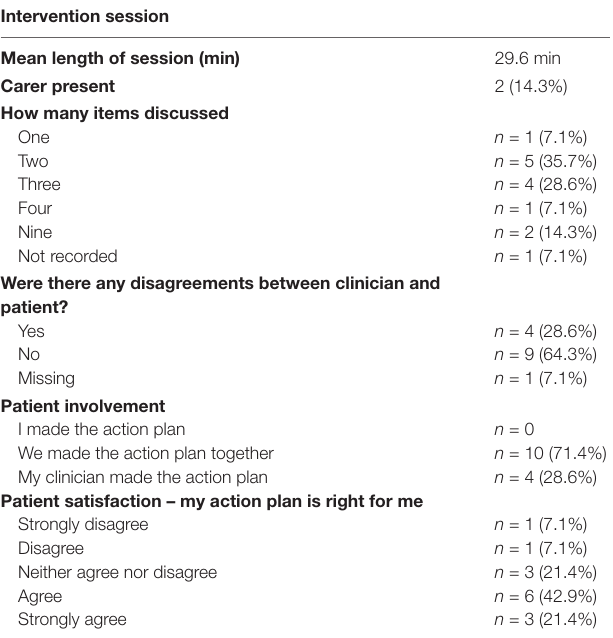
TABLE 2 | Intervention characteristics.